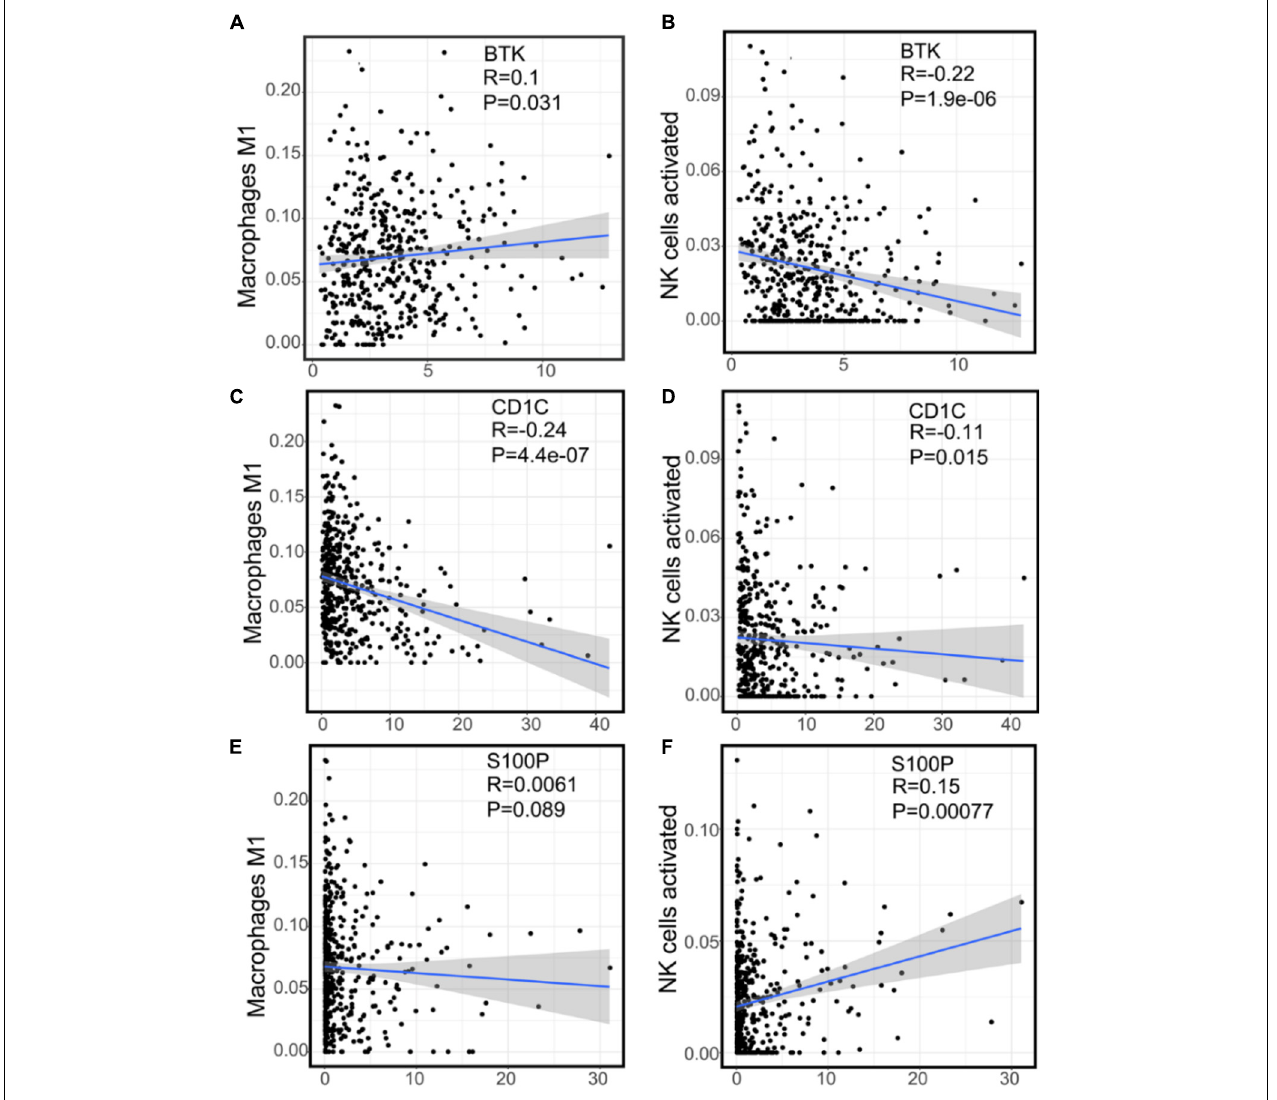
FIGURE 8 | The correlation between the expression of three immune genes and two kinds of prognostic immune cells. (A) The correlation scatter plot of the expression of BTK and M1 macrophages. (B) The correlation scatter plot of the expression of BTK and NK cells activated. (C) The correlation scatter plot of the expression of Cd1c and M1 macrophages. (D) The correlation scatter plot of the expression of Cd1c and NK cells activated. (E) The correlation scatter plot of the expression of S100P and M1 macrophages. (F) The correlation scatter plot of the expression of S100P and NK cells activated.